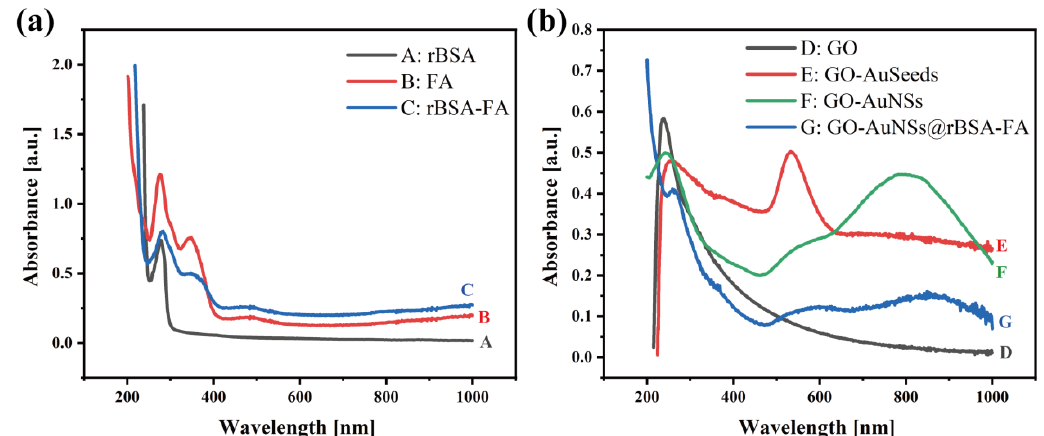
Figure 3. UV–vis absorption spectra of ( a ) GO, GO-AuSeeds, GO-AuNSs, GO-AuNSs@rBSA-FA and Figure 3. UV – vis absorption spectra of ( a ) GO, GO-AuSeeds, GO-AuNSs, GO-AuNSs@rBSA-FA ( b ) rBSA, FA, and ( b ) rBSA, FA, rBSA-FA.